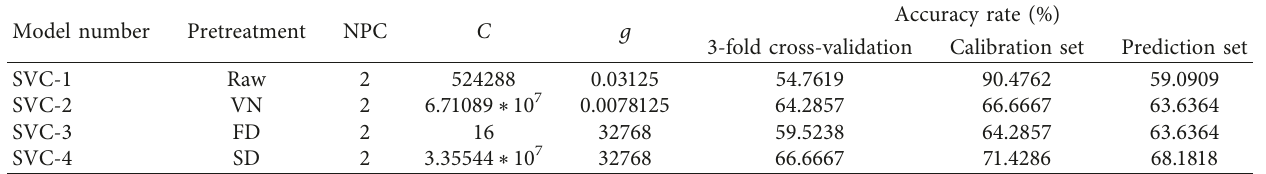
Table 3: Different spectral pretreatments of PCA-SVC models.